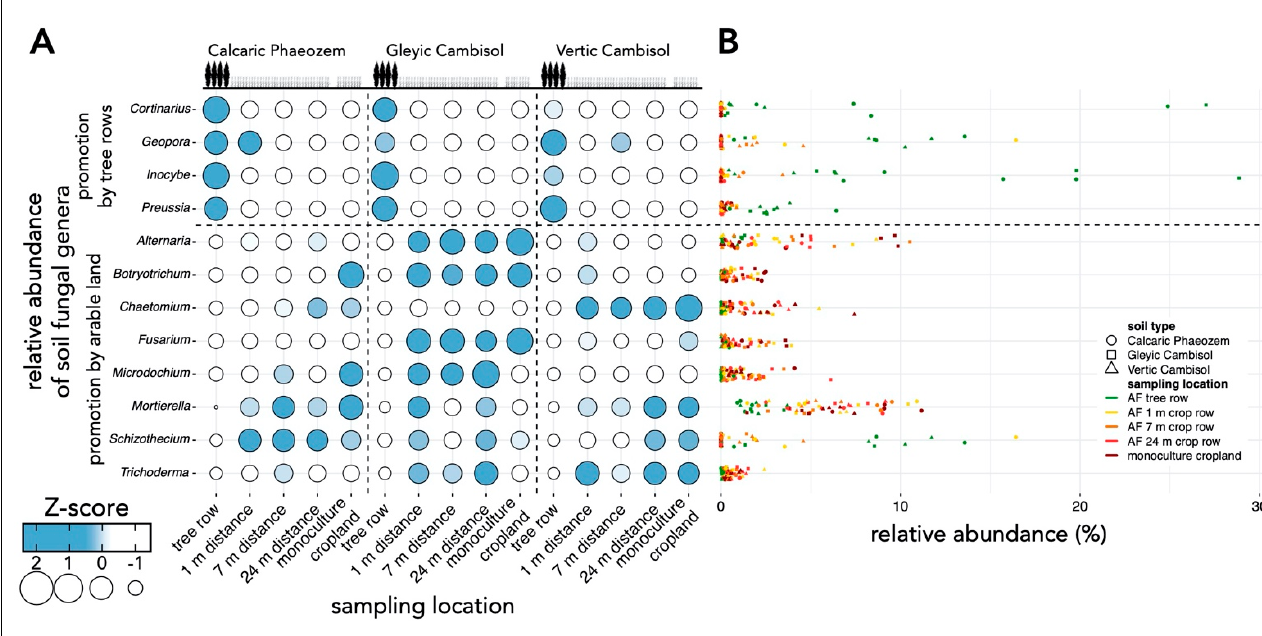
Figure 9. Relative abundance of selected soil fungal genera. ( A ) Mean Z-score normalized relative abundance of selected soil fungal genera ( n = 4). ( B ) Relative abundance of selected soil fungal genera. Relative abundances were calculated from ASV counts obtained by amplicon sequencing. Soil samples within each replicate plot of the temperate agroforestry croplands were collected in the centre of the tree row as well as in the crop row at 1, 7, and 24 m distance from the trees in order to cover the spatial heterogeneity of the systems. In the monoculture croplands, soil samples were collected in the centre of each replicate